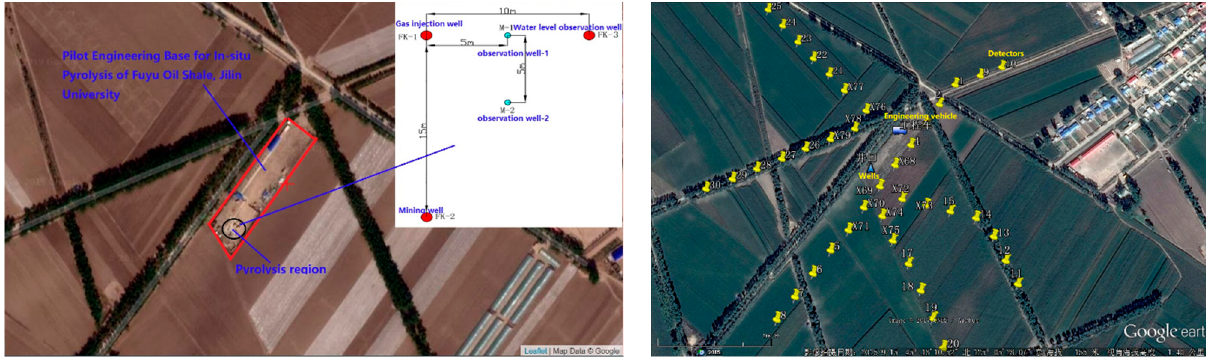
Figure 1. Wells location of oil shale in-situ pyrolysis and geophone deployment for monitoring hydraulic fracturing. (The yellow marks are representing the geophone).